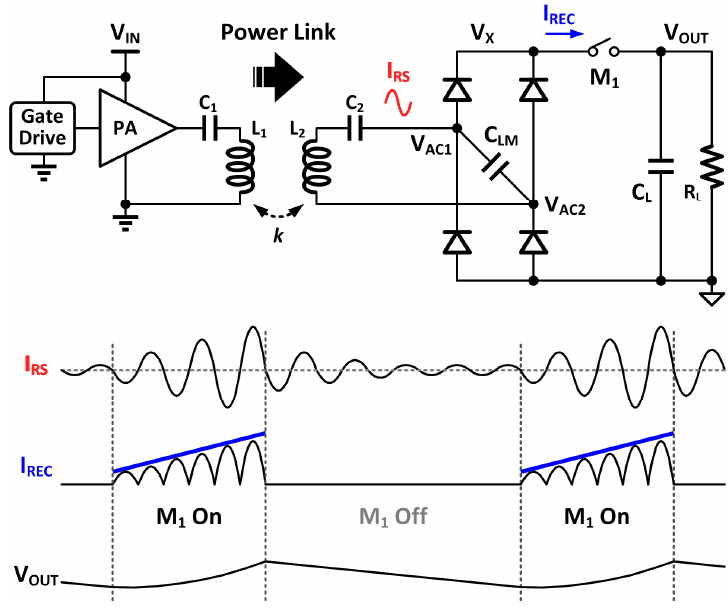
Figure 7. A resonant WPT system with one-switch pulse-width modulation regulating rectifier.